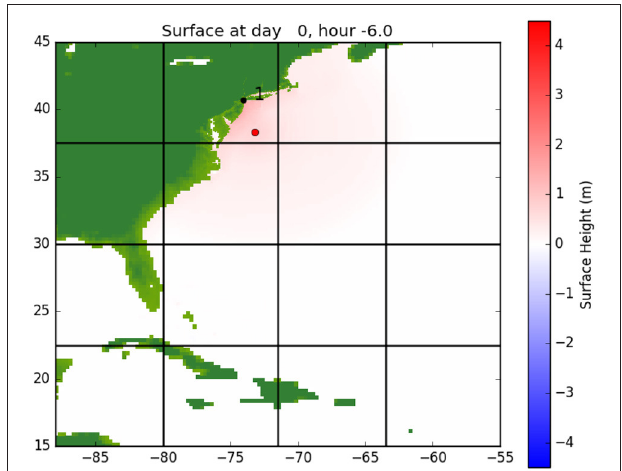
FIGURE 3 | A plot at 6 h before landfall of a G EO C LAW simulation of Hurricane Sandy. The red dot indicates the eye of the storm and the black dot (1) indicates Battery Park in Lower